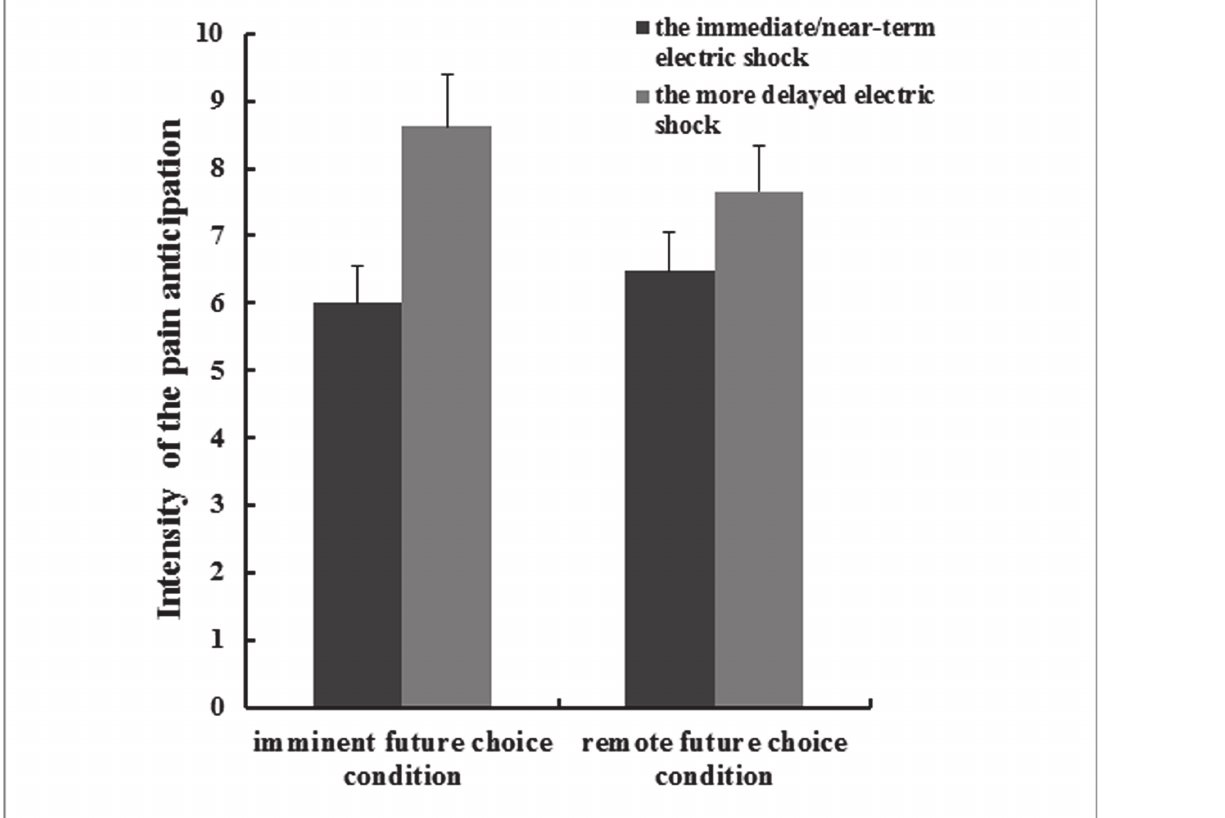
Fig 3. The average pain anticipation for the immediate/near-term electric shock and the more delayed electric shock in Study